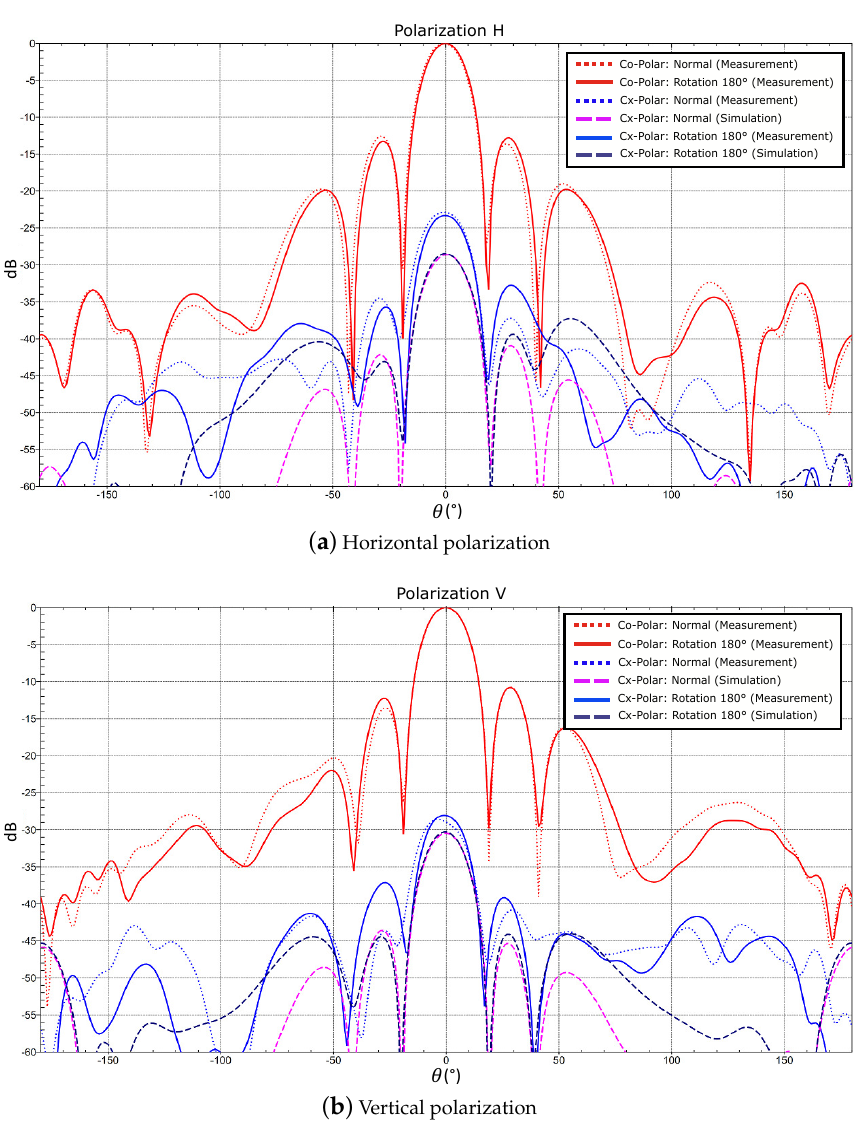
Figure 12. Comparison normal array and array with 180° rotation @ f 0 = 1.325 GHz: normalized co-polar and cross-polar patterns ( ϕ = 90 ◦ ). Uniform amplitude and phase